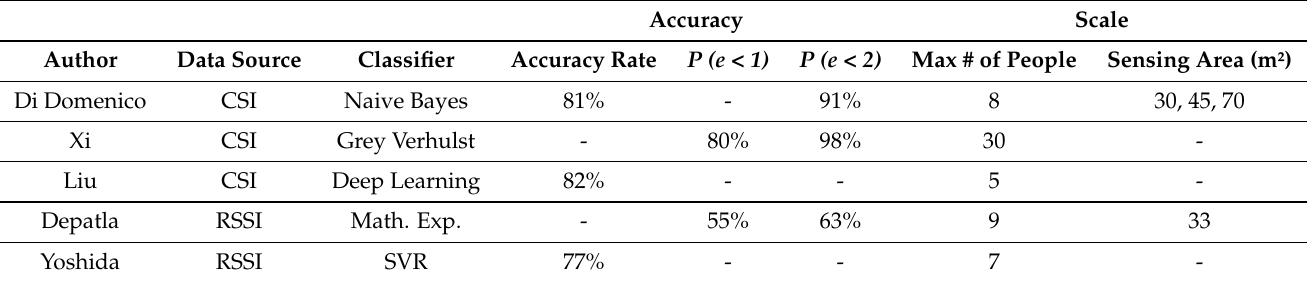
Table 1. Performance summary of crowd counting methods using commercial off-the-shelf (COTS) Wi-Fi. Accuracy